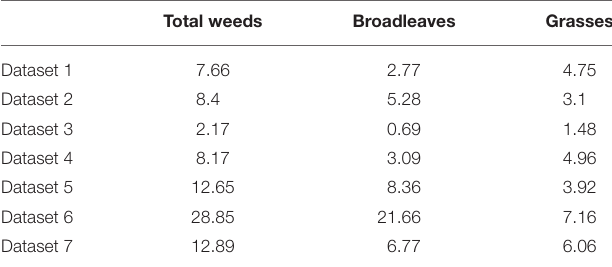
TABLE 4 | Most commonly occurring arable weed taxa recorded across seven studies of in winter